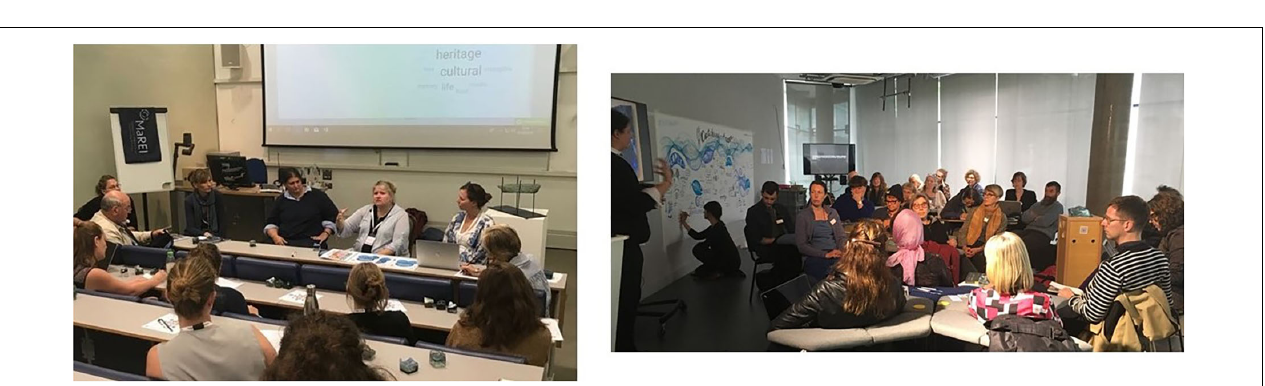
FIGURE 4 | Interactive CaW interactive workshops from (i) Society and the Sea, Greenwich (2018) and (ii) Art in the Anthropocene, Dublin (2019).